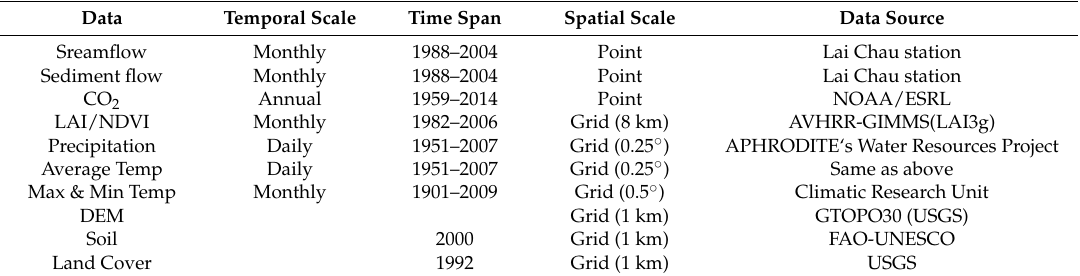
Table 1. A summary of input datasets for parameterizing different